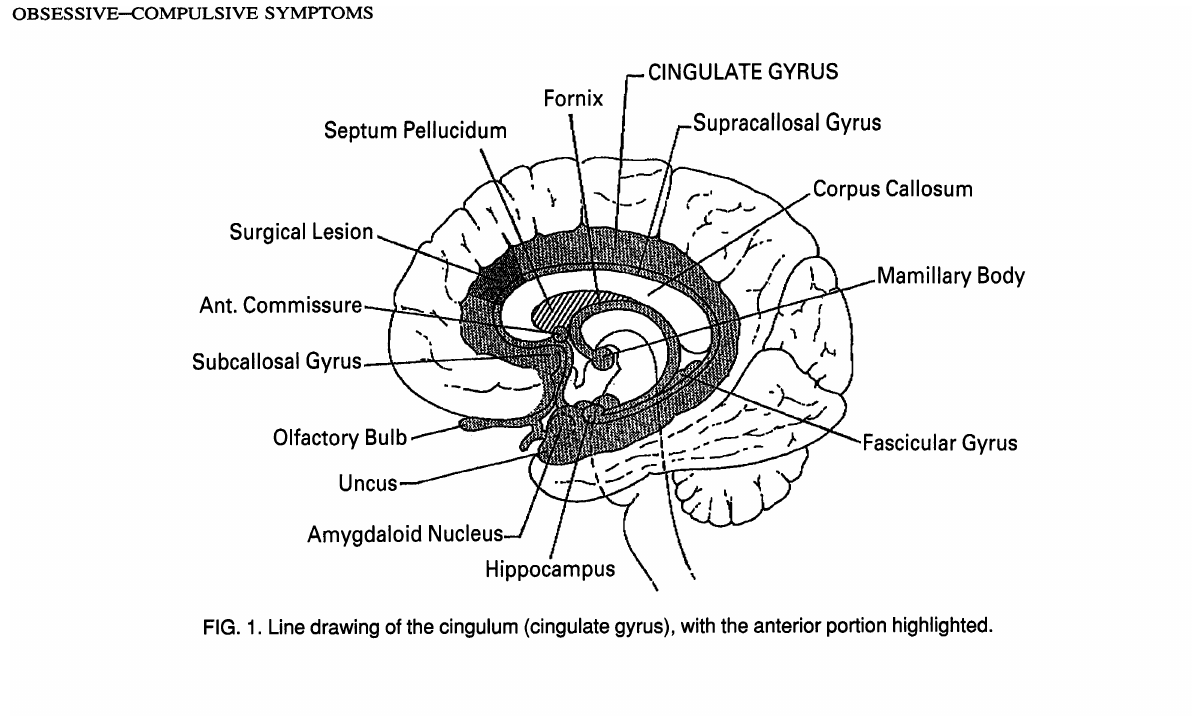
FIG. 1. Line drawing of the cingulum (cingulate gyrus), with the anterior portion